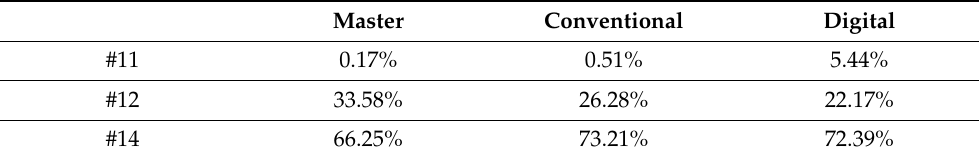
Figure 5. Percentage force distribution by tooth (%). Table 2. Percentage force distribution by tooth